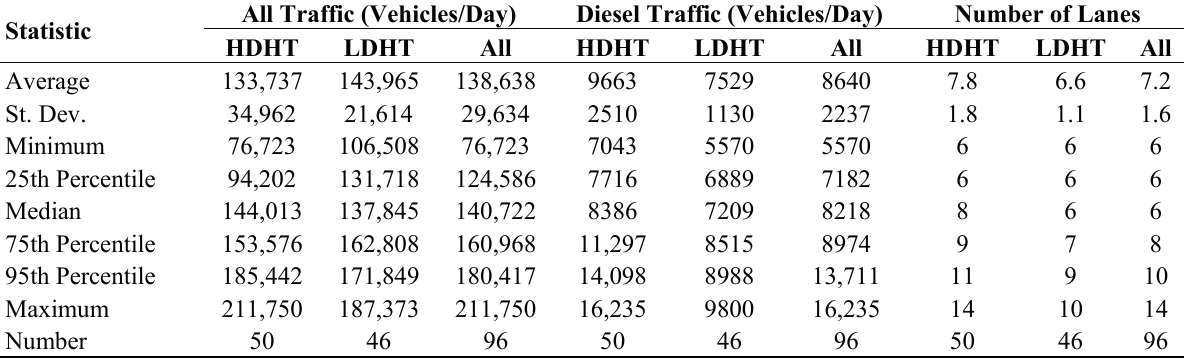
Table 1. Statistics of AADT volume, diesel traffic volume, and number of lanes for the nearest highways at the high traffic (HDHT and LDHT) homes. Maximum values are affected by the three homes had equal distance to two highways (both were